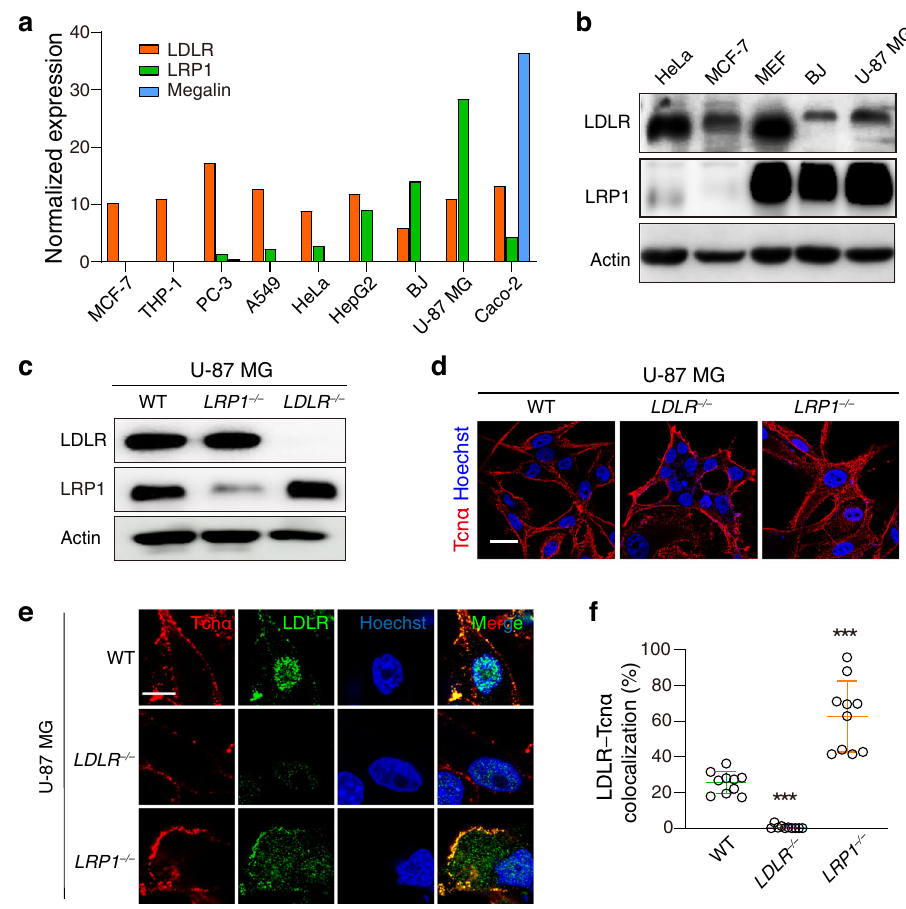
Fig. 4 LDLR versus LRP1 in various cells. a The mRNA levels of LDLR, LRP1, and Megalin in MCF-7, THP-1, PC-3, A549, HeLa, HepG2, BJ, U-87 MG, and Caco-2 cells are shown. Data were obtained from a public database (http://www.proteinatlas.org). b The protein levels of LDLR and LRP1 in the HeLa, MCF, MEF, BJ, and U-87 MG cells were measured by immunoblot analysis. c The depletion of LDLR and LRP1 in the U-87 MG LDLR ‒ / ‒ and LRP1 ‒ / ‒ cells showed by immunoblot analysis. Actin served as a loading control. The experiments in b , c have been repeated independently twice with similar results. d Immuno fl uorescence analysis shows that Alexa Fluor 555-labeled Tcn α (50 nM) is robustly bound to the U-87 MG WT, LDLR − / − , and LRP1 − / − cells. Cell nuclei were stained with Hoechst dye. Representative images are shown. The scale bar represents 50 μ m. e Immuno fl uorescent staining shows cellular localization of LDLR and endocytosed Tcn α in the U-87 MG WT, LDLR − / − , and LRP1 − / − cells. Cell nuclei were stained with Hoechst. Representative images are shown. Scale bars represent 10 μ m. f Colocalization of LDLR and endocytosed Tcn α in the U-87 MG WT, LDLR − / − , and LRP1 − / − cells were analyzed by software ImageJ ver1.53. The percentage of the Tcn α signals that overlapped with LDLR in each cell was calculated and plotted as an open circle. Error bars ( n = 10) indicate mean ± SD, *** P < 0.001 versus WT, two-sided Student ’ s t